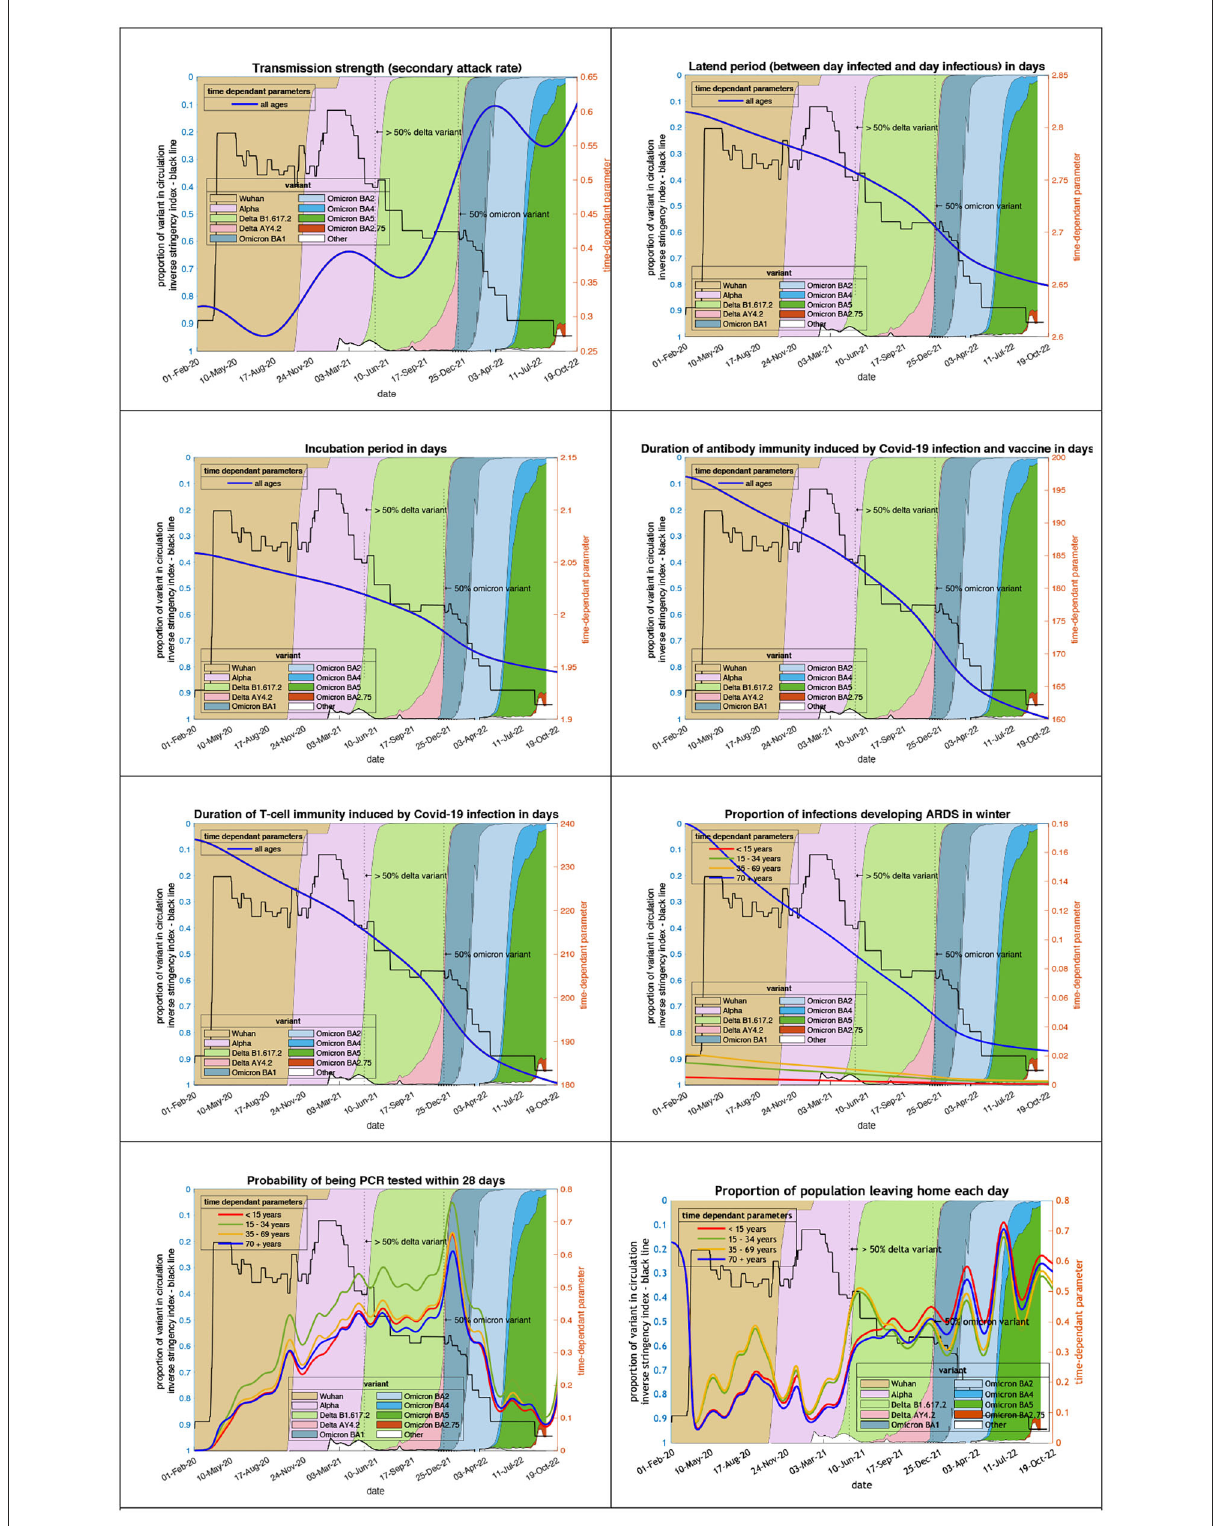
FIGURE1 Changing estimates of transmission and immune profiles in relation to the emergence of new variants and changes in response to public health policies: UK February 2020 to October 2022. Note: Transmission strength is measured as the secondary attack rate with prior value of 0.2 (i.e., an infected person infects 1 in 5 contacts), which rises with the newer variants to 0.5 (i.e., one infection infects 1 in 2 contacts); antibody immunity which falls with newer variants is measured in days of